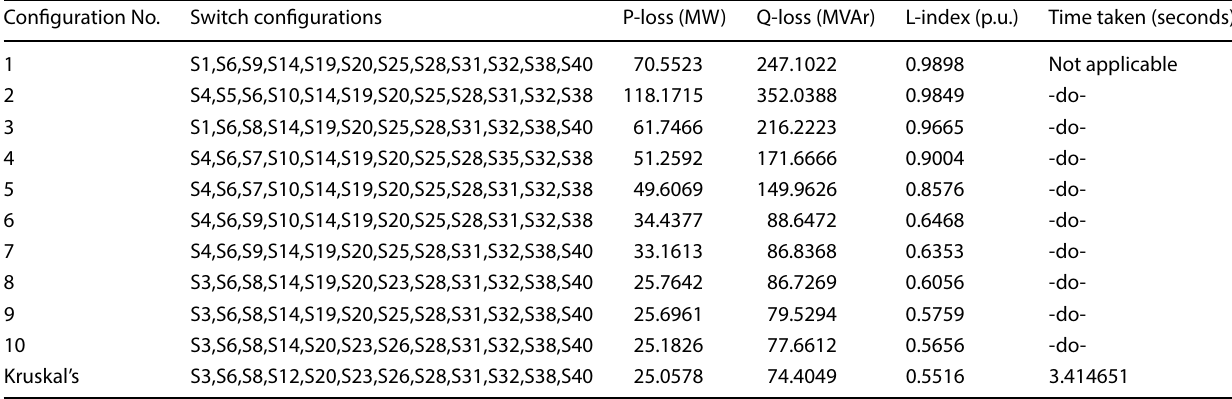
Table 3 Calculated values of L-index, P-loss, and Q-loss at base loading scenario Configuration